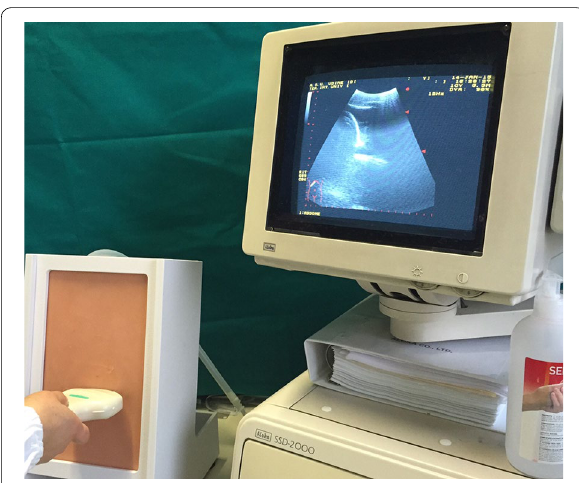
Fig. 1 The thoracentesis simulator ‘Ultrasound Thoracentesis Model THM-30’ developed by SIMULAB, Seattle, USA. It features a partial torso with anatomical landmarks, such as skin texture, ribs, and a fluid reservoir. Its simulated lung is seen as an echogenic structure with an inflating mechanism to adjust the size of the pleural effusion